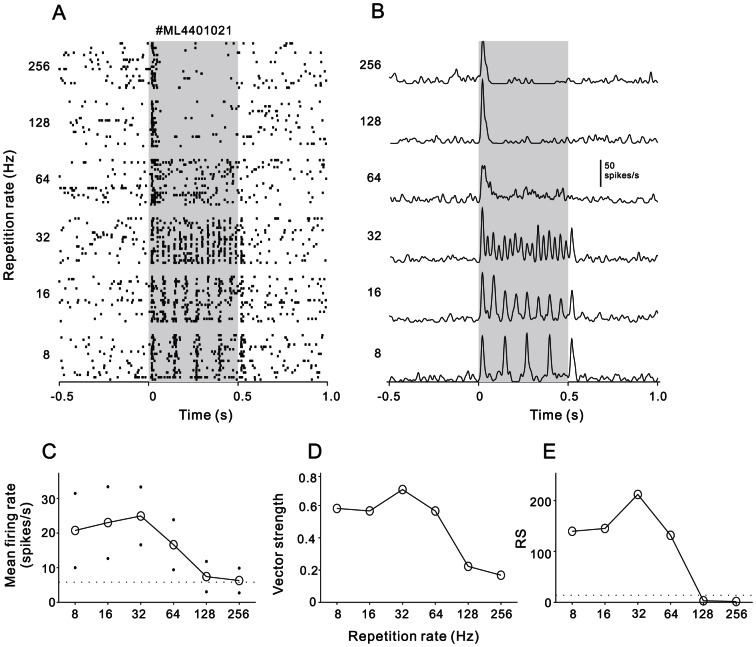
An example neuron showing stimulus-synchronized responses.(A) Raster plots of neural spikes in response to 20 repetitions of 8–256 Hz click-trains. Each dot represents one action potential. Shaded gray region shows the stimulus duration. (B) PSTH representing the firing rate averaged across the 20 trials of each stimulus condition (1-ms bin, smoothed by Gaussian function with 5-ms SD). (C) Mean firing rate as a function of the repetition rate. Dots indicate the SD. Dashed horizontal line shows the background firing rate. (D) Vector strength as a function of the repetition rate. (E) Rayleigh statistic for neuronal response shown in (A). Responses to 8–64 Hz click-trains beyond the criteria for statistical significance (13.8, P<0.001) which is indicated on the plot with a dashed horizontal line.